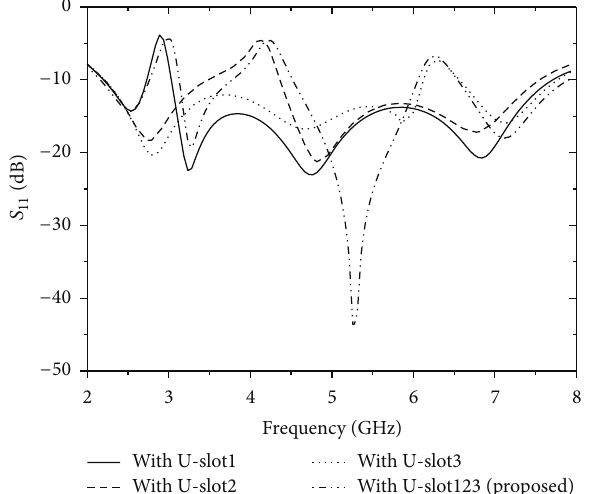
Figure 5: Frequency behavior of the scattering parameter 𝑆 11 for the multiband antenna with one, two, and three